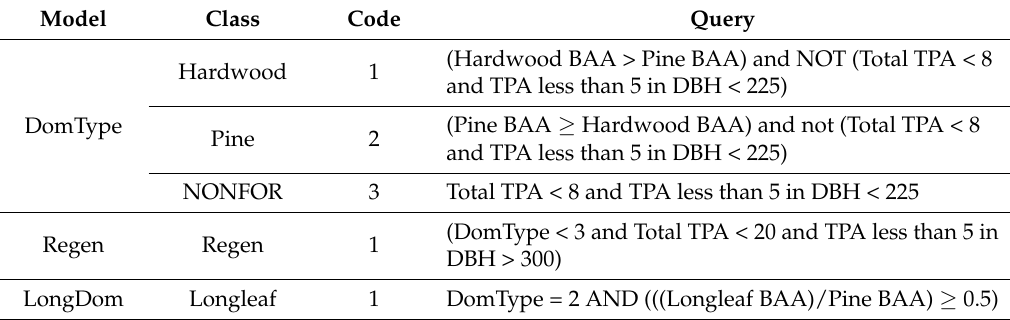
Table 3. Logical rules used to categorize DomType, Regen, and Longleaf classes within Forest Inventory Analysis (FIA) plot